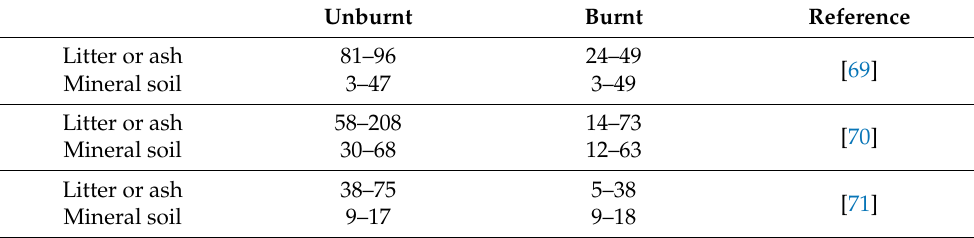
Table 5. Total mercury concentrations in burnt and unburnt soils, litter and ash ( µ g kg − 1